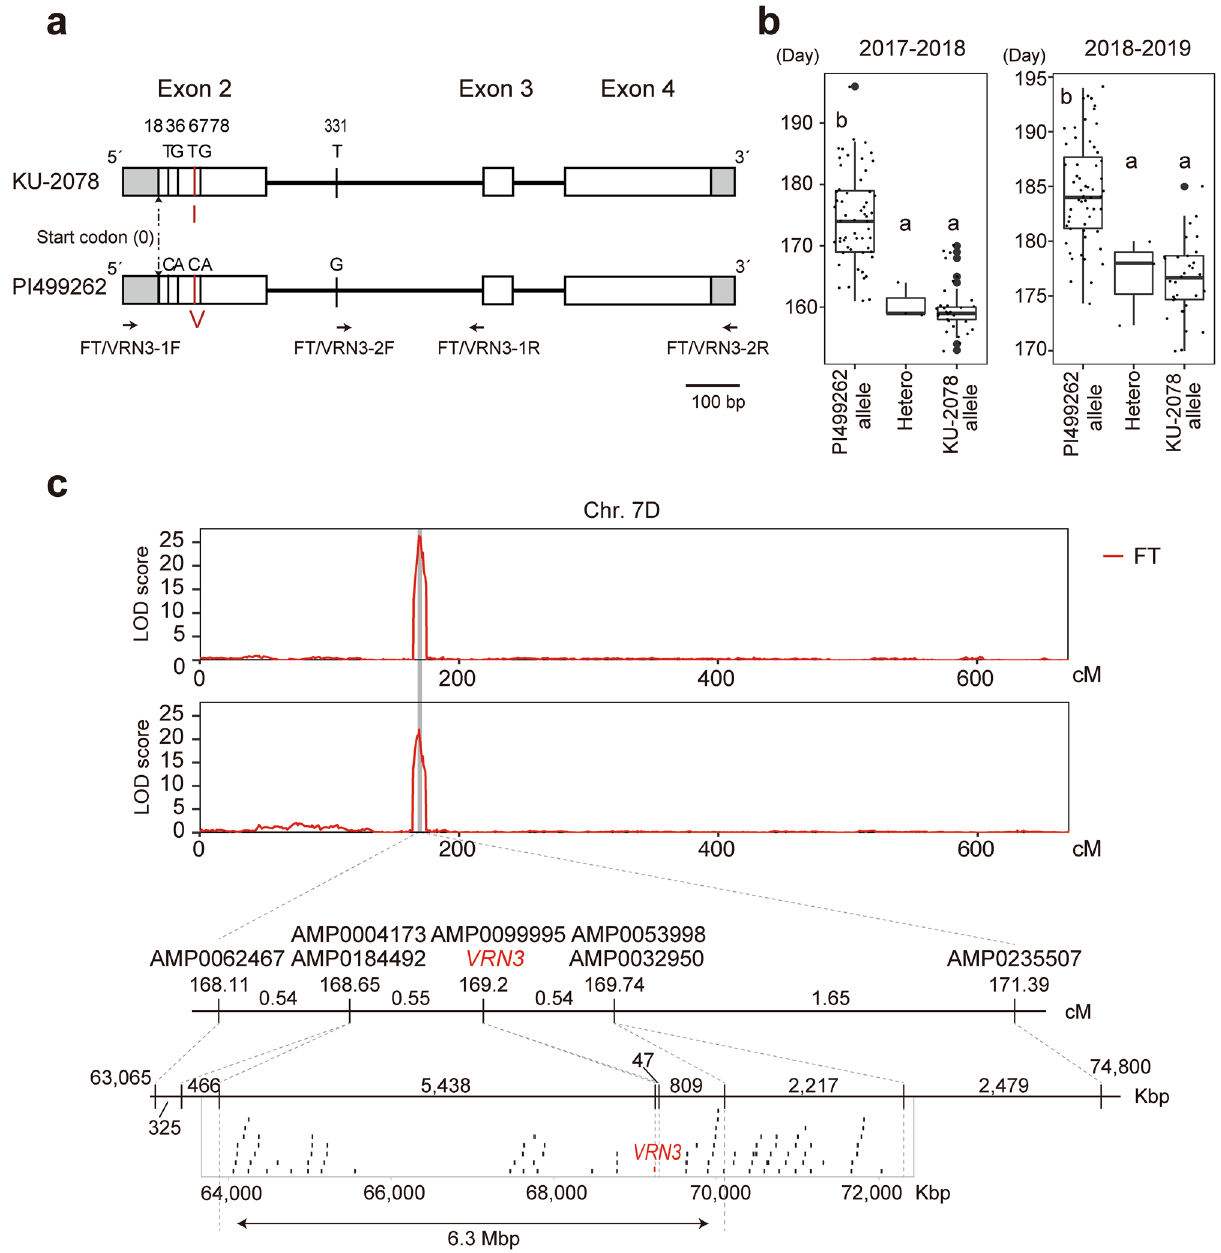
Figure 4. The wheat flowering locus VRN3 was linked to the 7D QTL marker with the highest LOD score for flowering time. ( a ) Polymorphic sites in VRN3 between the parental accessions KU-2078 and PI499262 of Ae. tauschii . White boxes are exons. Grey boxes are UTRs. Vertical bars indicate polymorphic sites. The red bar indicates the nonsynonymous substitution designed for the CAPS marker. The sites of primers for sequencing and the CAPS marker are shown with black arrows. ( b ) Box and dot plots of flowering time between the different genotypes (PI499262/PI499262 homozygous allele, PI499262/KU-2078 heterozygous allele, and KU-2078/KU-2078 homozygous allele) at VRN3 in the Ae. tauschii KU-2078/PI499262 RILs in the 2017–2018 and 2018–2019 seasons. The same letters indicate no significant difference (P > 0.05, Tukey–Kramer HSD test). ( c ) Distribution of LOD scores for flowering time (FT) over the linkage map corresponding to chromosome 7D after removal of the RILs with the heterozygous genotype at VRN3 . Enlarged view of the linkage map around VRN3 and its corresponding physical map are shown below the distribution of LOD scores. Locations of genes between two markers, AMP004173 and AMP0053998, are shown as black and red dots below the physical map. The red dot is the location of VRN3 . Plots were created with the R packages ggplot2 (Wickham 2016) and GenomicFeatures (Lawrence et al.